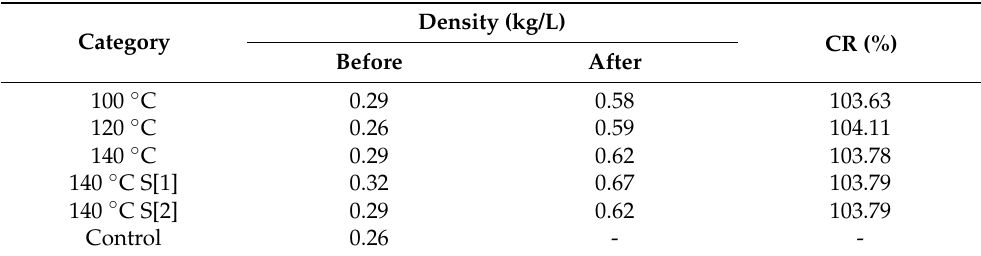
Table 5. Correlation between Albizia falcataria density and compression